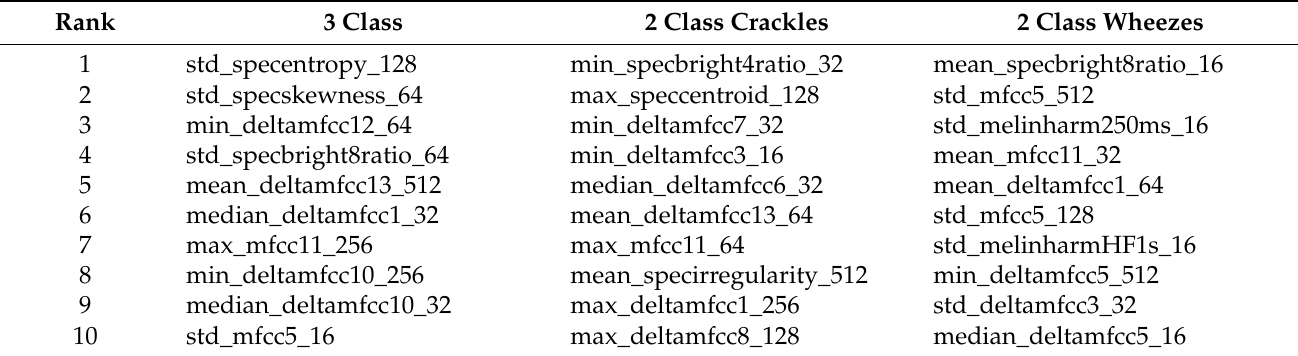
Table 7. Ten highest-ranked features (variable